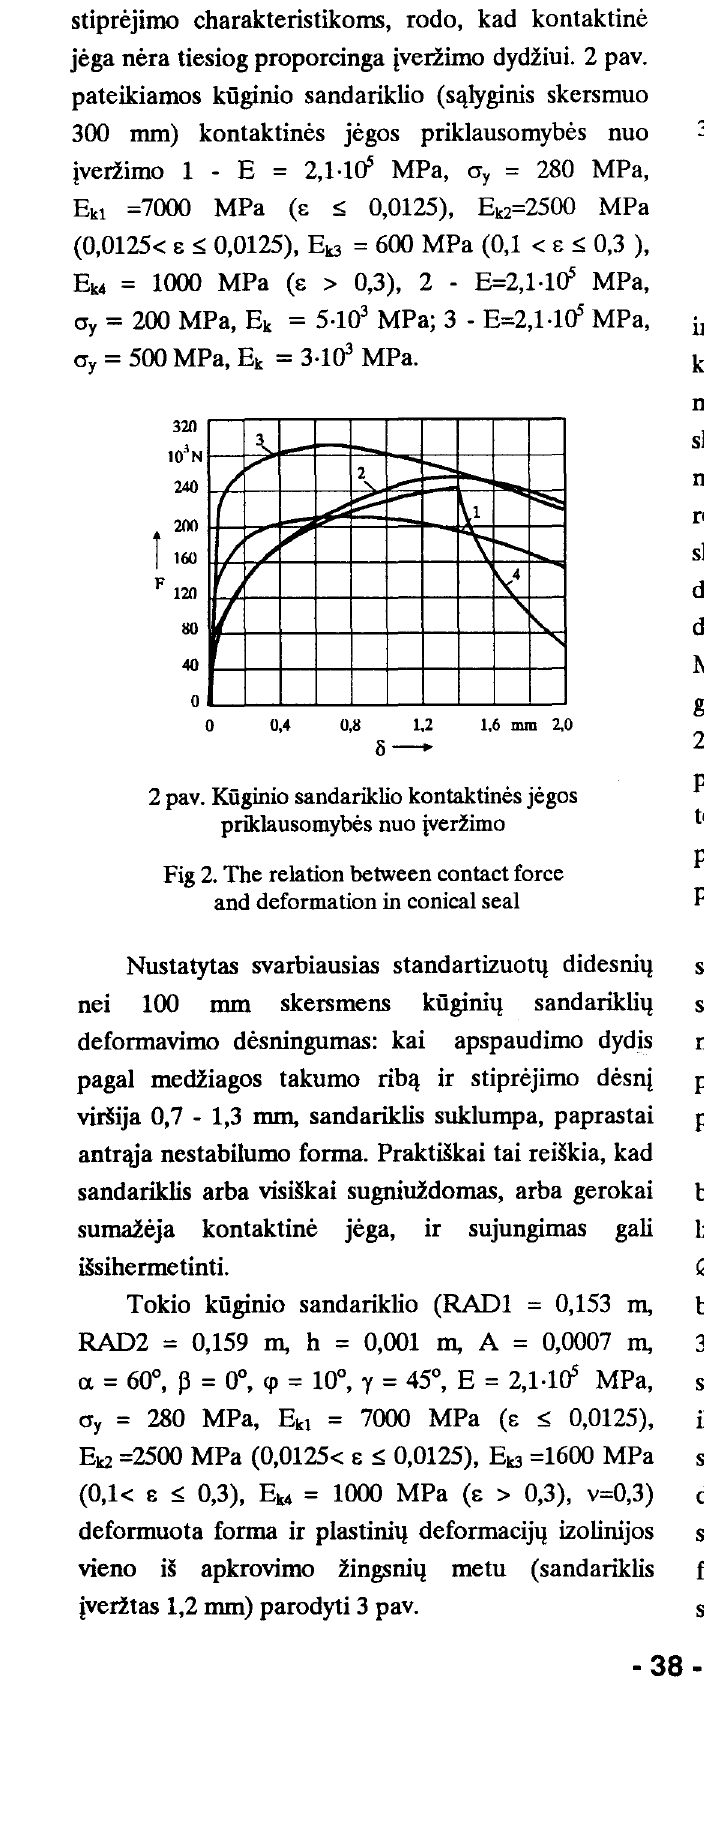
Fig 3. Contours of equivalent plastic strains of conical